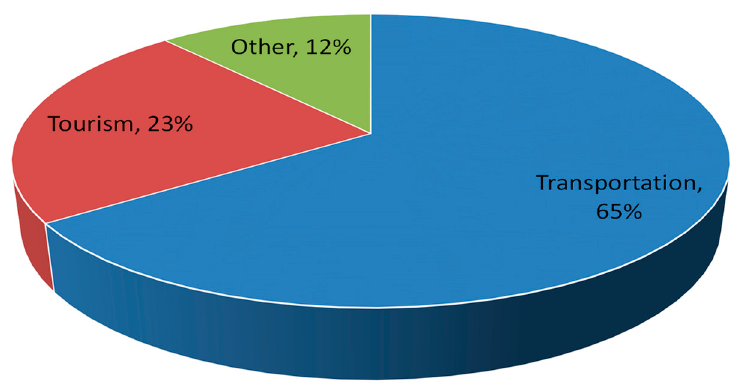
Figure 8. Electric and hybrid vessels.